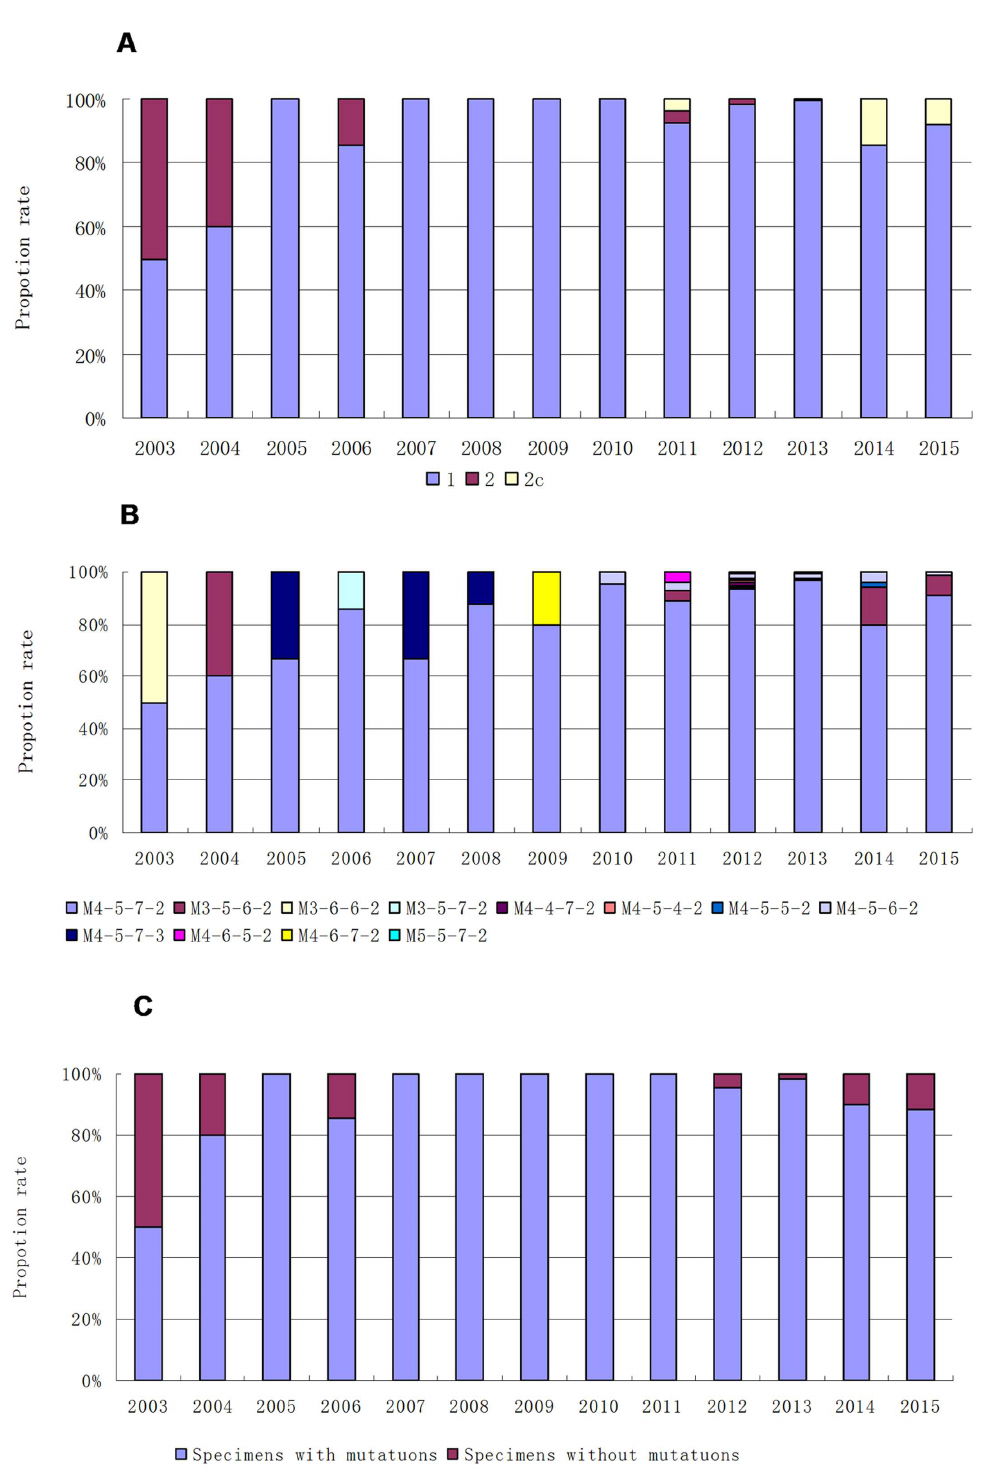
Fig 1. Prevalence rates of the different genotypes and macrolide resistance mutations by year. (A) Prevalenceof the different P1genotypes from 2003–2015. (B) Prevalence of the different MLVA genotypes